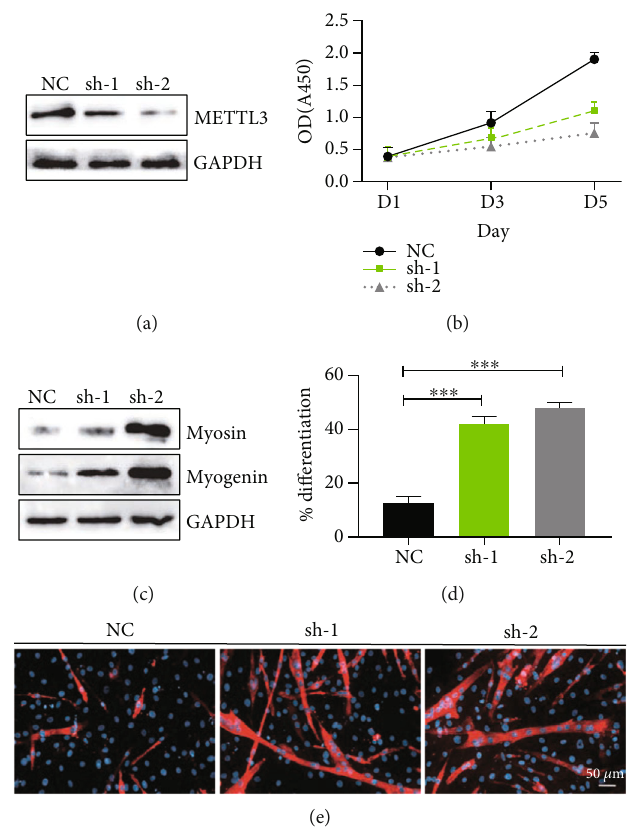
Figure 5: Deletion of METTL3 a ff ects C2C12 myoblast progenitor cell proliferation and di ff erentiation. (a) Western blot detection of METTL3 expression. (b) Proliferation ability signi fi cantly decreased after METTL3 knockout determined by cell counting Kit-8 at indicated days. (c) Western blot analysis of the expression of early di ff erentiation marker myogenin and late di ff erentiation marker myosin in C2C12 cells. (d) Myosin staining (red) was performed 3 days later using an anti-myosin antibody, and the nuclei were counterstained with DAPI. (e) Di ff erentiation index in the METTL3-depleted and control cells. Data represent mean ± SEM . ∗∗∗ p < 0 : 001